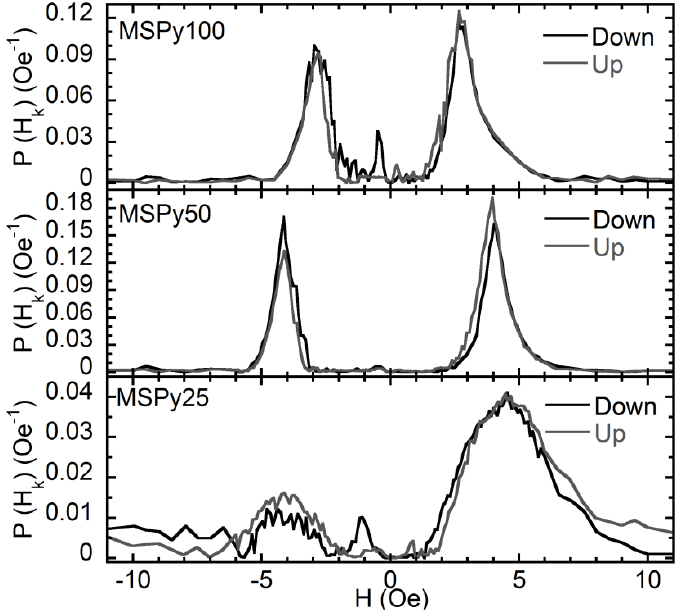
Figure 3. Distribution of perpendicular anisotropies from the second harmonic